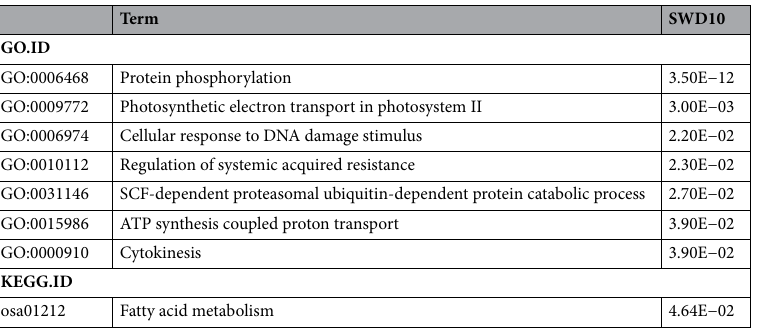
Table 2. Enriched GO terms and KEGG pathways between SWD10 and SWR66 at 0